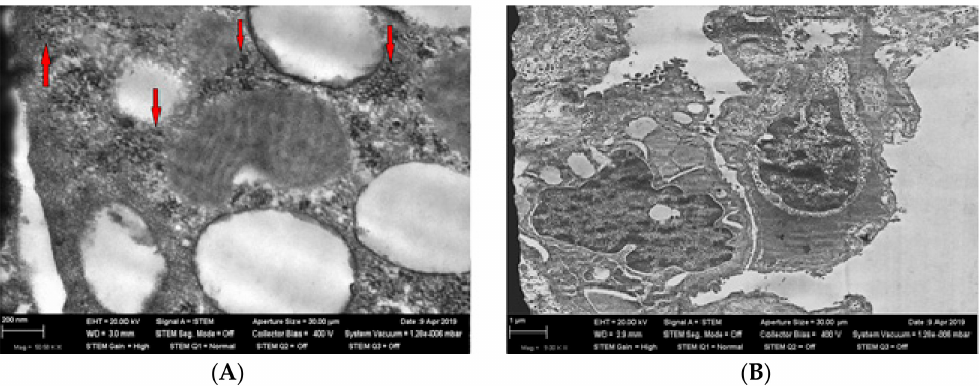
Figure 2. Panel ( A )—nanoparticles (shown by red arrows) in alveolocytes of type 2 (TEM, magnification × 50,580) in rat lungs from the exposed group. Panel ( B )—alveolocytes of type 2 (TEM, magnification × 9000) in rat lungs from the control (sham-exposed) group.